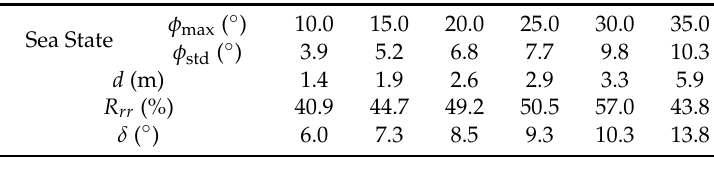
Table 2. Control performances of PFA-RRR in different sea states.